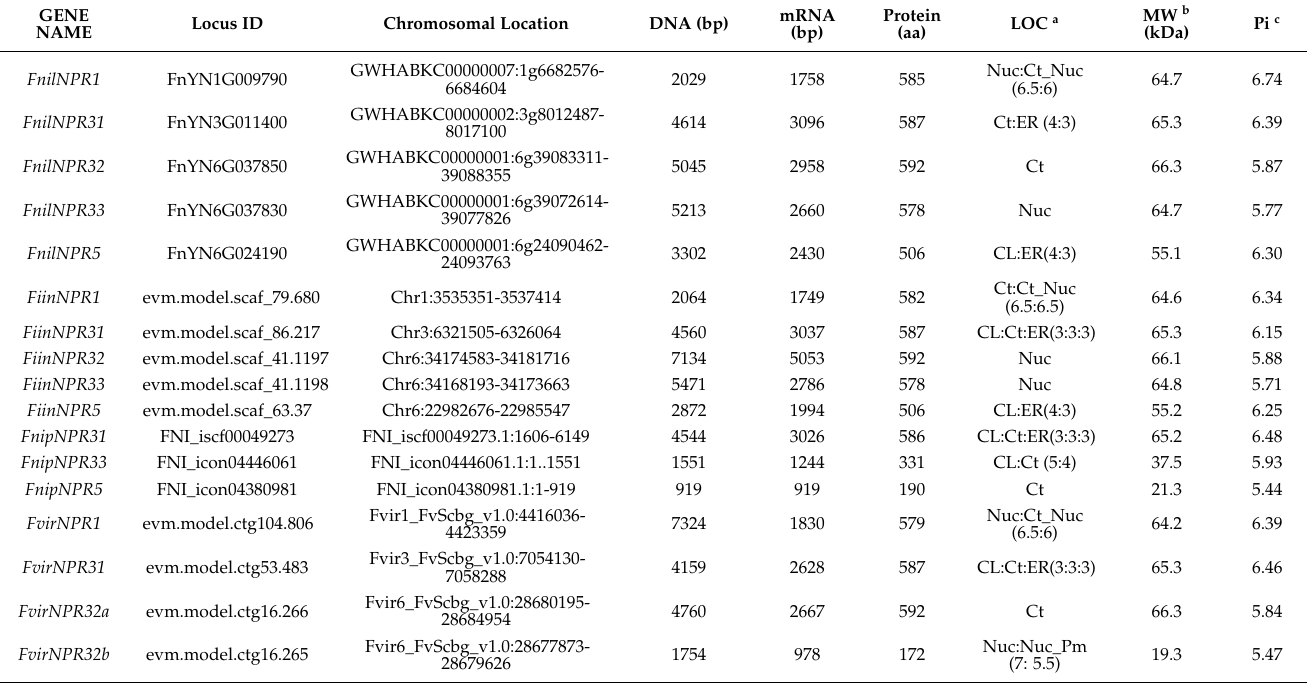
Table 1. The genomic and biochemical information for NPR genes identified in diploid and octo- ploid